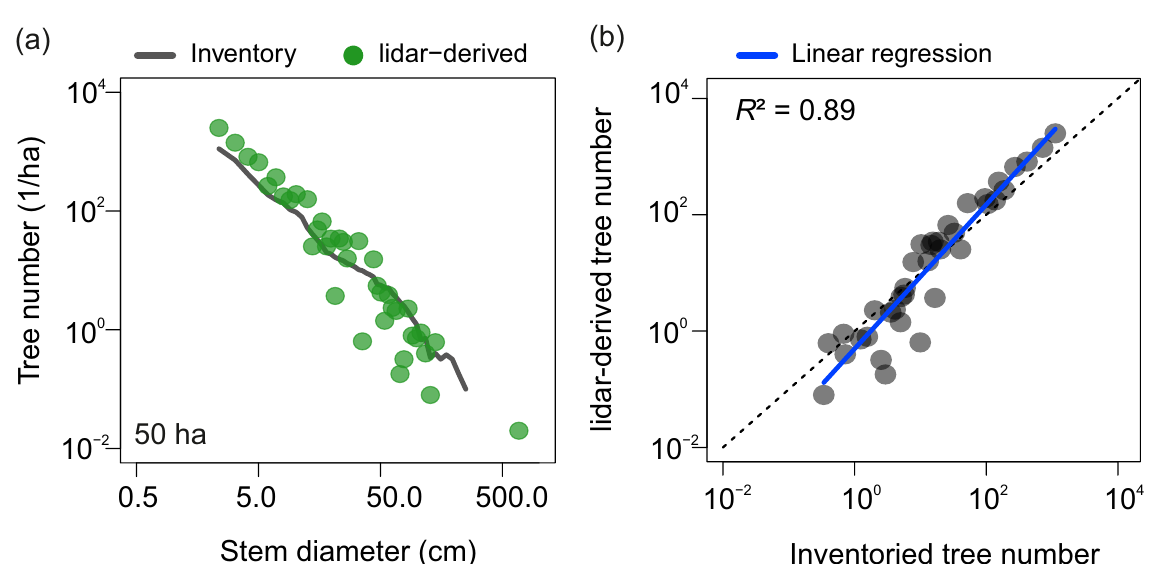
Figure 3. Comparison of the stem diameter distribution derived from lidar with field data at BCI (50 ha). ( a ) The tree number per stem diameter class derived from lidar (green points) and field inventory (grey line) of BCI on log–log axes (see methods for details). ( b ) 1:1 plot of the comparison on log–log axes including a linear regression line (blue line) for evaluation. Grey dots represent the logarithmic tree numbers for each stem diameter class comparing those derived from lidar (y-axis) and those censused in the inventory ( x -axis). For the root mean square error ( RMSE ) (22.8 trees per ha) and normalized RMSE ( nRMSE ) (6.2%) values, we refer to the methods and Table 3.